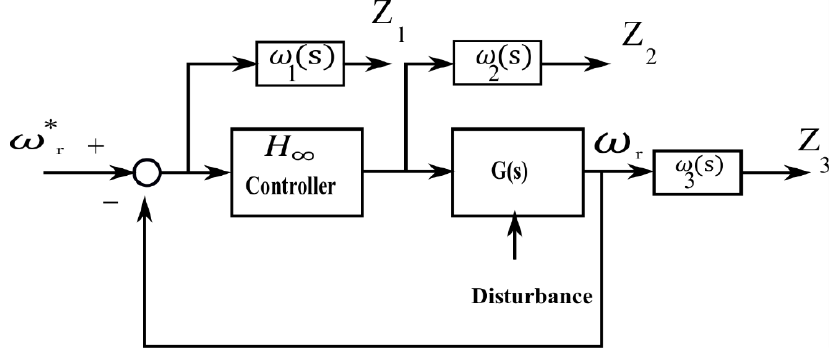
Figure 7. Plant with weighting functions for 𝑯 ∞